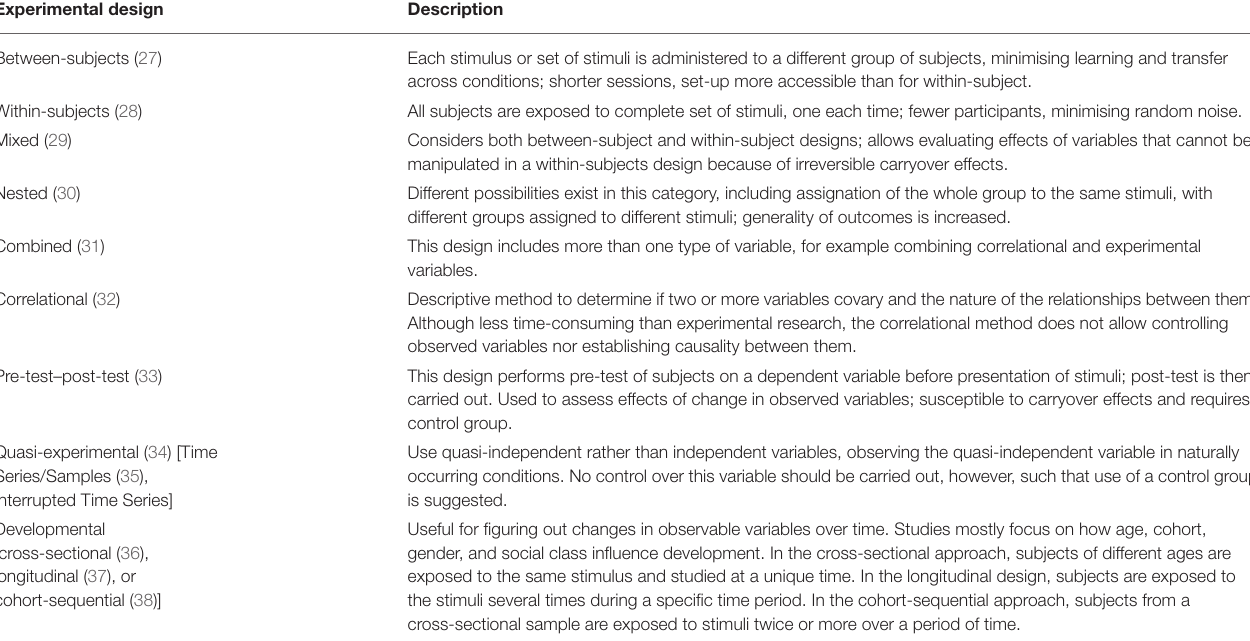
TABLE 1 | Experimental designs and their description (25, 26). Experimental